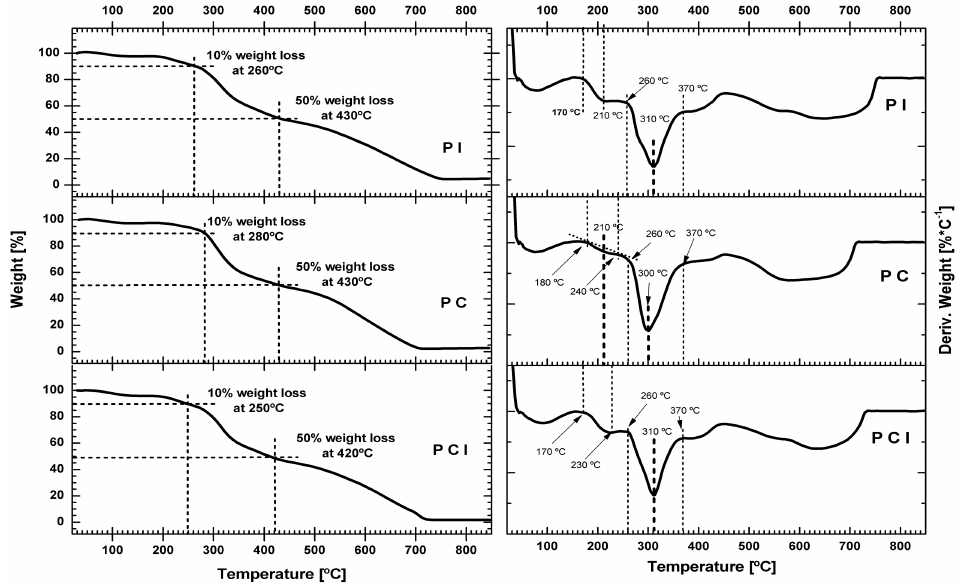
Figure 3. On the right; TG curves of the thermal degradation and on the left; DTG curves of the thermal degradation of blends.